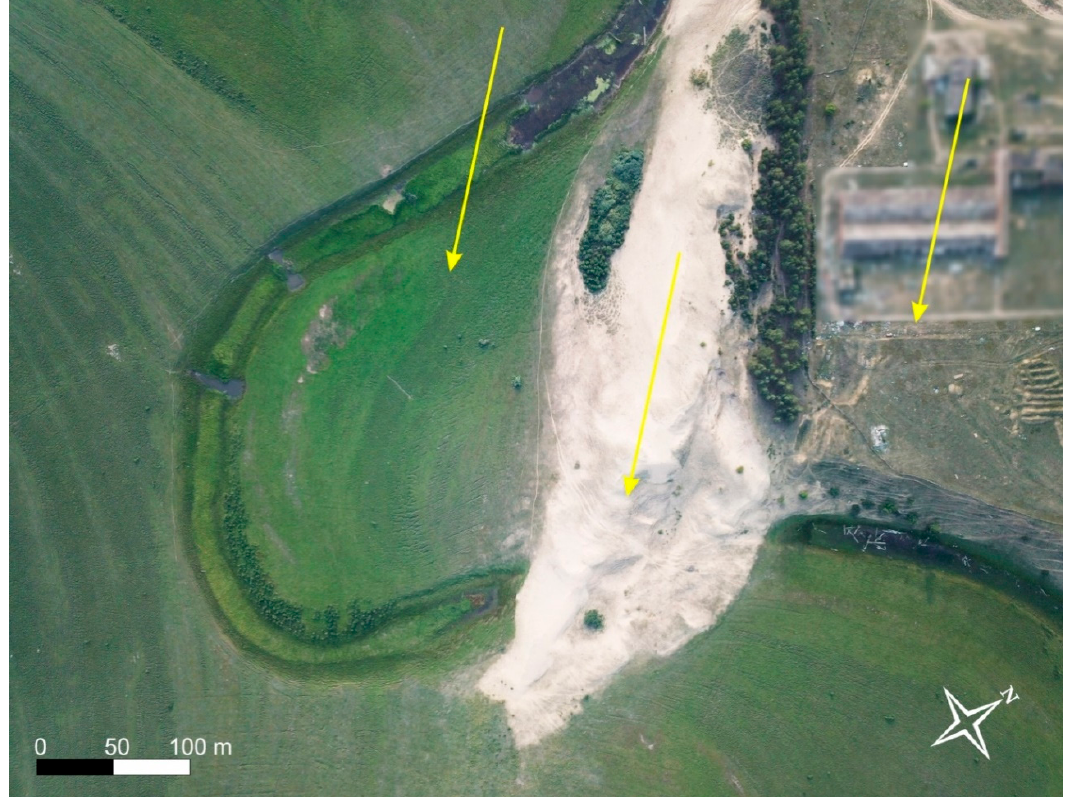
Figure 11. Dune field blocked the channel in the Selenga delta near the village of Kudara (2018).